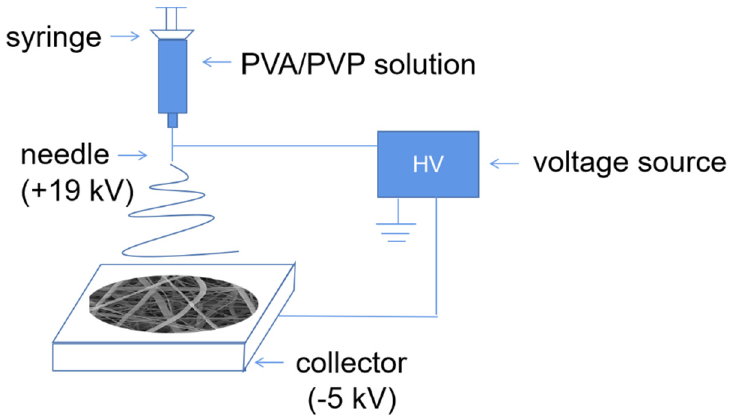
Figure 1. Setup of the experimental electrospinning apparatus.